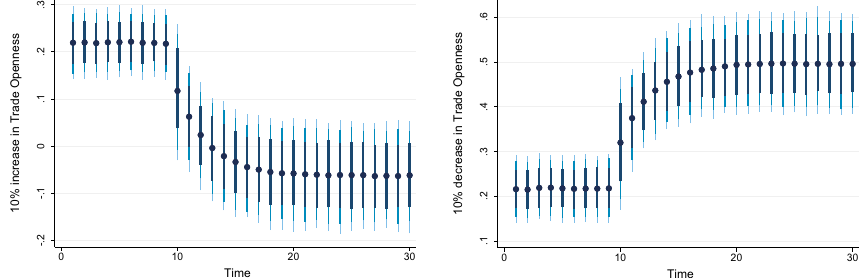
Fig. 7 The Impulse Response Plot for Trade Openness and CO 2 Emissions. Figure 7 presents an increase and a decrease by 10% in trade openness and its effect on CO 2 emissions where dots denote average prediction value. The dark blue to light blue line shows 75, 90, and 95% confidence interval, respectively